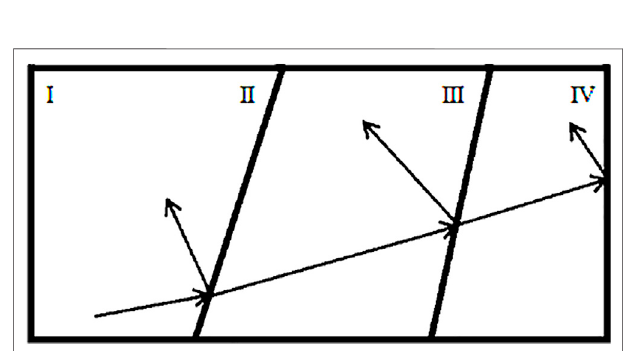
Frontiers in Materials |